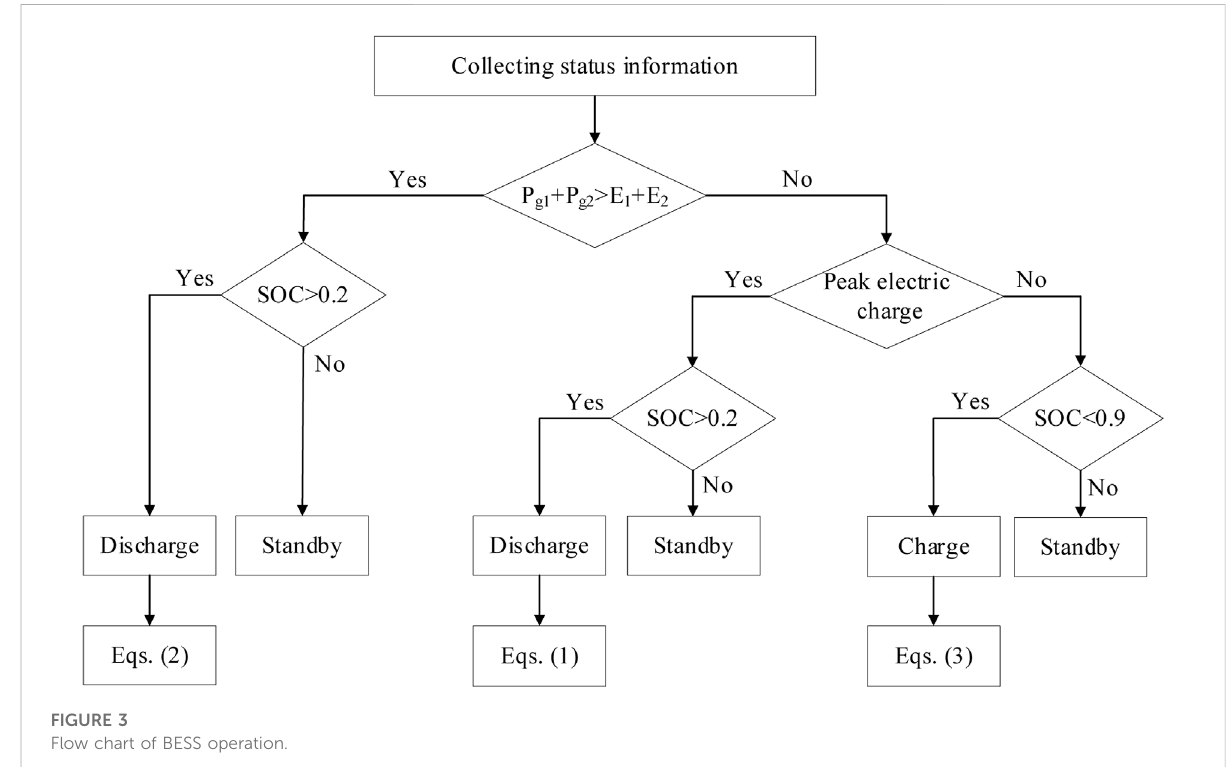
FIGURE 3 Flow chart of BESS